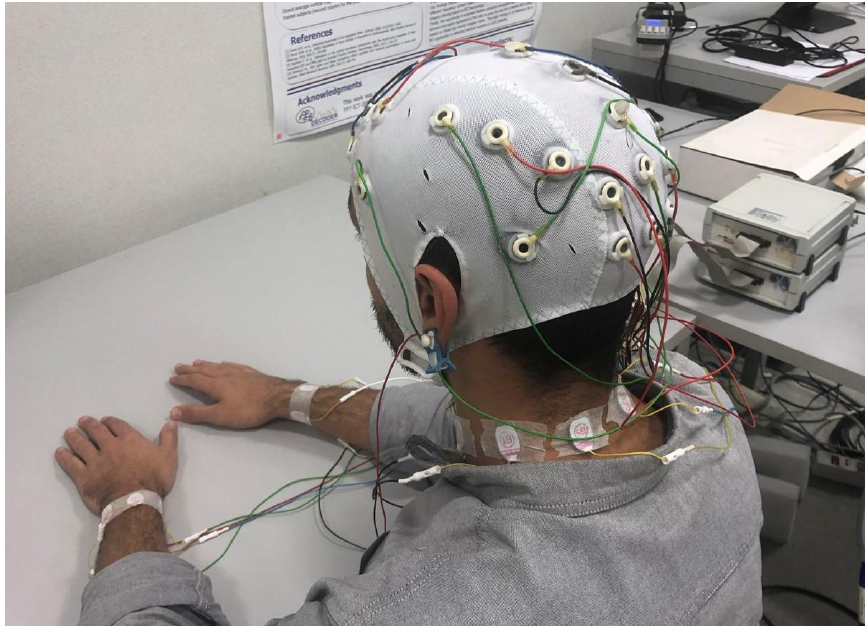
Figure 1. Participant wearing the electroencephalogram (EEG) cap and the noEEG sensors around the neck and wrists while seating comfortably and keeping the eyes